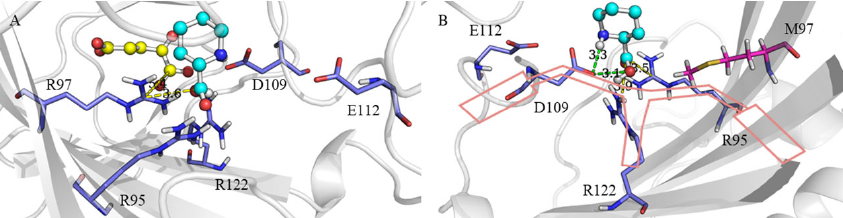
Figure 7. Comparison of the substrate-binding mode between the cis -P3H and R97M. ( A ) The “handlebar” binding mode of cis -P3H active pocket: salt bridge (yellow dashed line). ( B ) The “handlebar” binding mode of R97M active pocket: hydrogen bond (green dashed line) and salt bridge (yellow dashed line).